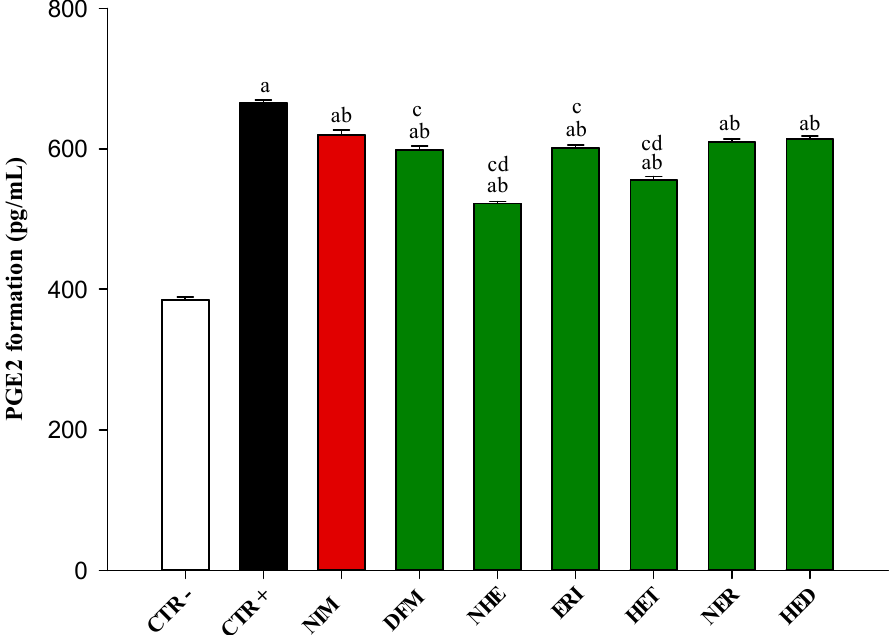
Figure 4. Prostaglandin (PGE2) release upon exposure of Caco-2 monolayers to 10 mM arachidonic acid (AA) after treatment with 25 ng/mL IL-1 β . CTR − , negative control treated only with 10 mM AA; CTR+, positive control treated both with 25 ng/mL IL-1 β and AA; NIM, nimesulide, used as reference standard; DFM, 10 µ M digested flavanone mix; NHE, 10 µ M neohesperidin; ERI, 10 µ M eriocitrin; HET, 10 µ M hesperetin; NER, 10 µ M neoeriocitrin; HED, 10 µ M hesperidin. a p < 0.001 vs. CTR − ; b p < 0.001 vs. CTR+; c p < 0.05 vs. NIM; d p < 0.05 vs. DFM.